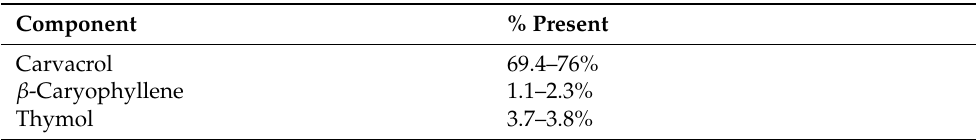
Table 1. Three main components of the oregano essential oil utilized in this study. Percentages were obtained from data sheets available on the company’s website (https://www.planttherapy.com/, accessed on 4 August